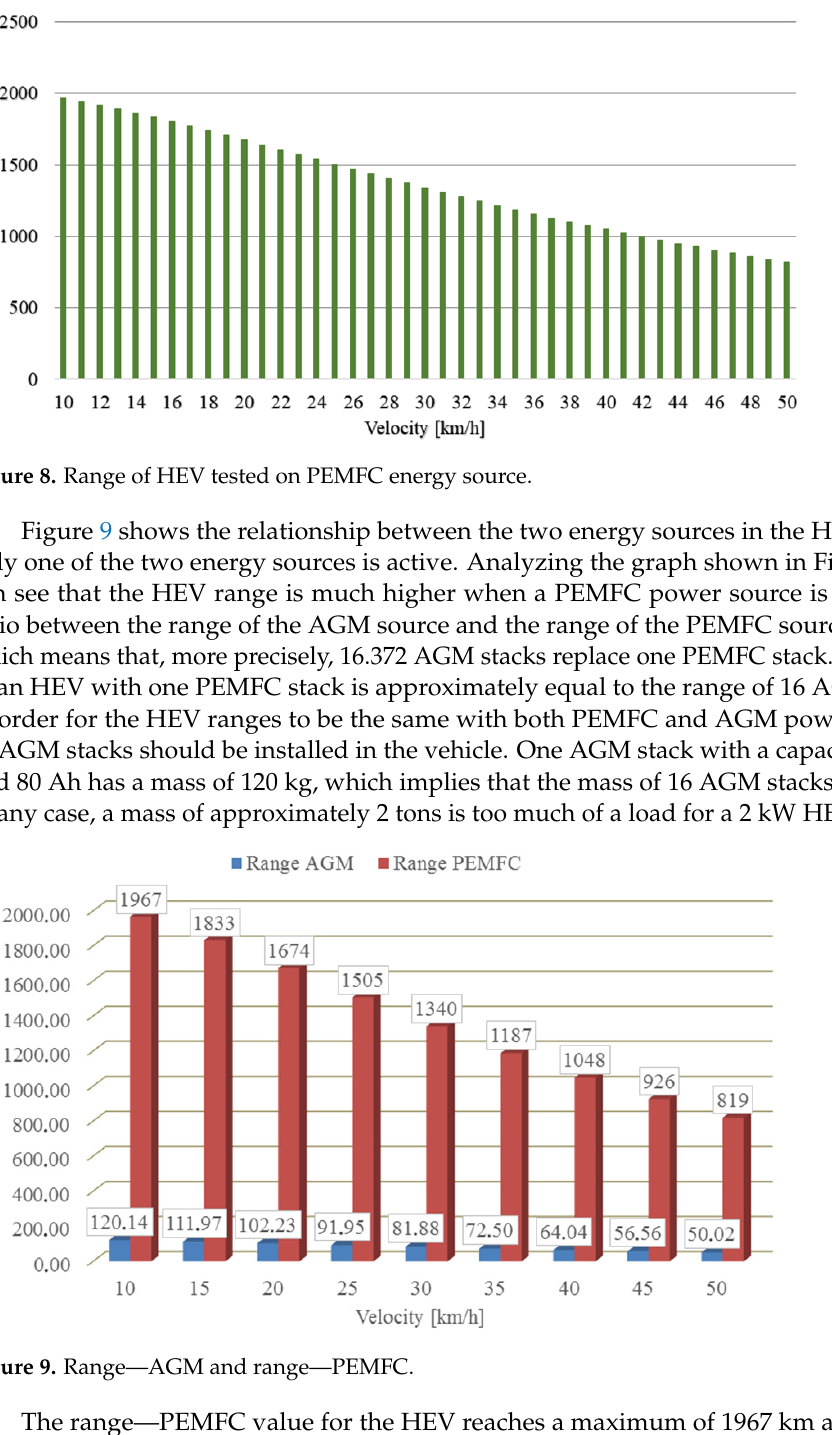
Table 2. Velocity’s relationship to Contribution and Benefit.